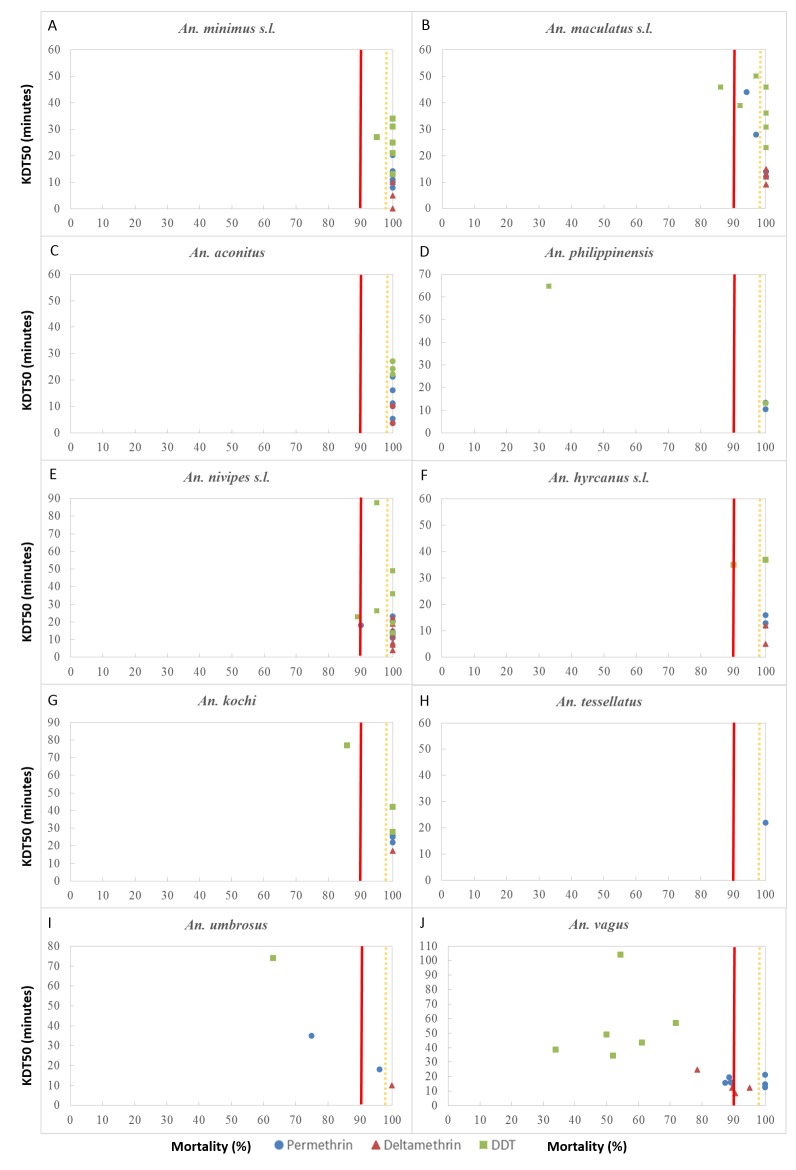
Time for 50% knockdown (KDT50) versus mortality for 10 Anopheles species from Lao PDR against 3 insecticides (permethrin 0.75% designated with a blue circle, deltamethrin 0.05%designated with a red triangle, DDT 4% designated with a green square).The solid red line indicate the WHO threshold for insecticide resistance (<90% mortality) The orange dotted line indicate suspected resistance (90%<mortality<98%).